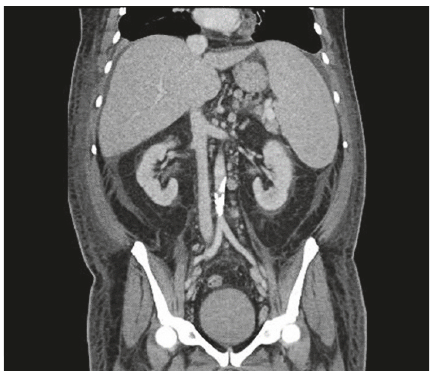
Figure 1: Pretreatment CT with contrast showing enlarged intra- abdominal nodes and